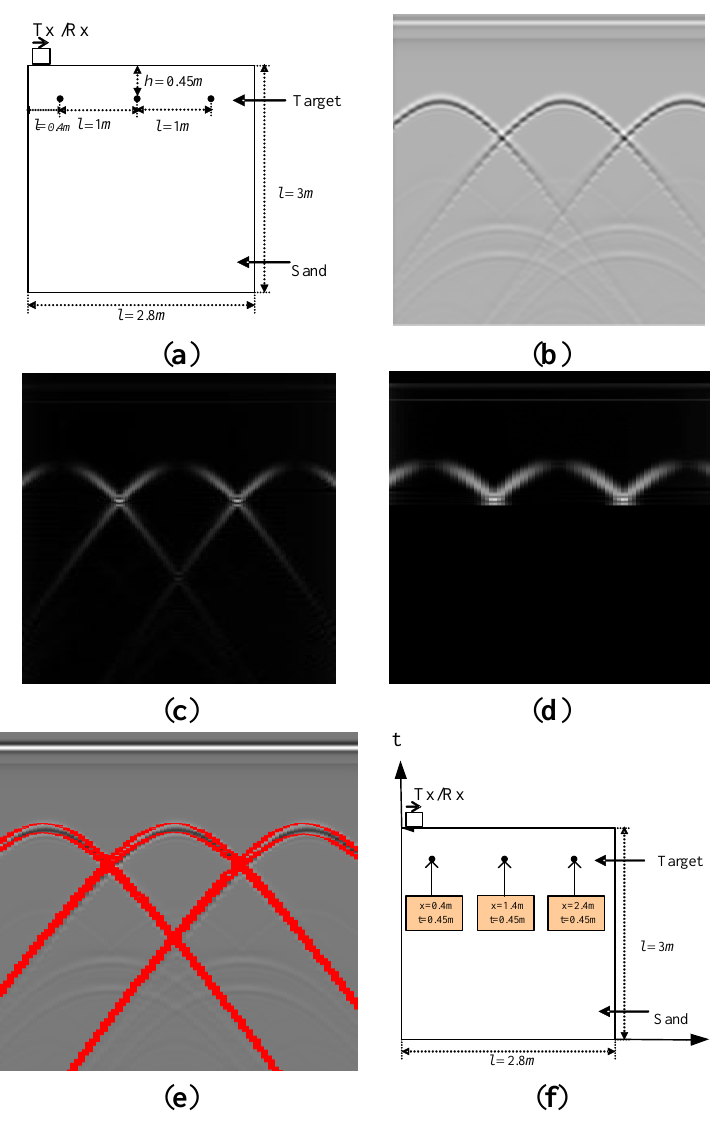
Figure 6. Example of MMSA detection result. ( a ) The location in reality; ( b ) GPR image; ( c ) Extraction of the amplitude component using MMSA; ( d ) Extraction the ROI of the amplitude component; ( e ) The hyperbola result of the Hough transform; ( f ) The position estimation result of the detection method.